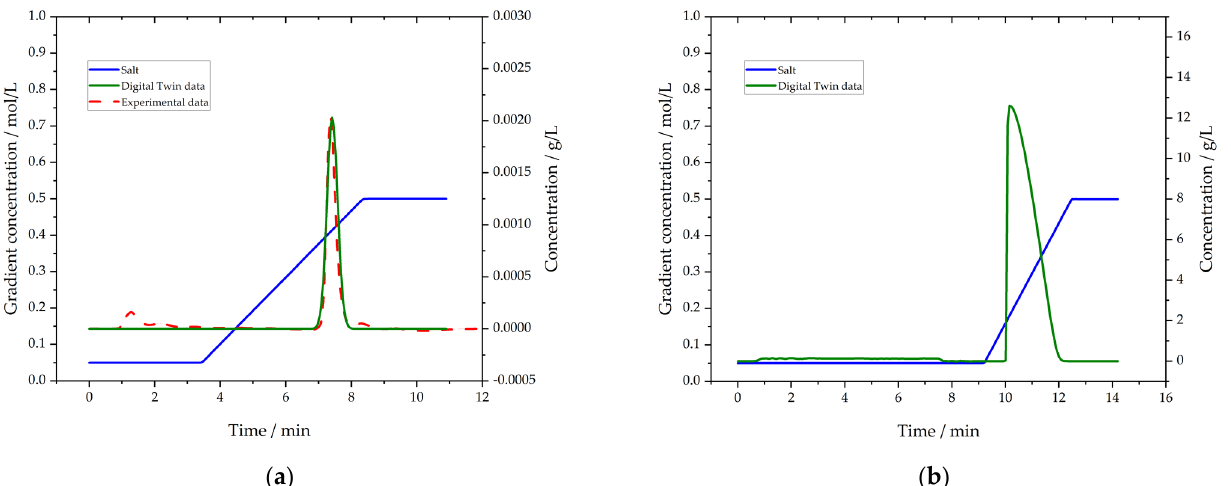
Figure 10. Chromatogram of the laboratory ion exchange chromatography ( a ) (dashed) and scaled-up process ( b ) with the digital twin results (green solid), respectively. The gradient is given as a blue solid line.